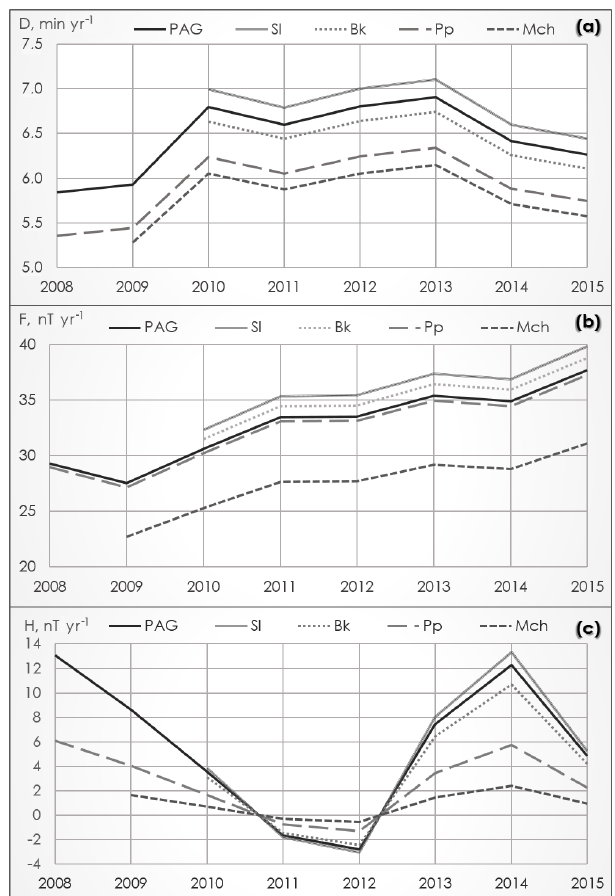
Figure 2. Extrapolated element secular variation for four repeat sta- tions (Slavotin, Bekleme, Popovo, and Michurin): (a) declination D (arcminyr − 1 ), (b) total intensity F (nTyr − 1 ), and (c) horizon- tal component H (nTyr − 1 ) from the last measurement campaign started in 2007 up to 2015. It is calculated for a single year for a single component using Eq. (3). PAG secular variation for the cho- sen period is also plotted for each component.